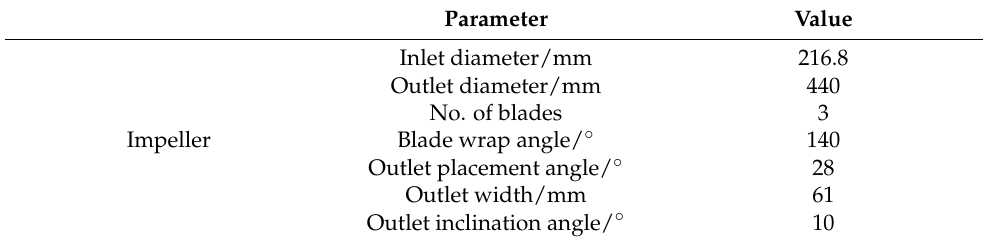
Table 1. Geometric parameters of model pump impeller.